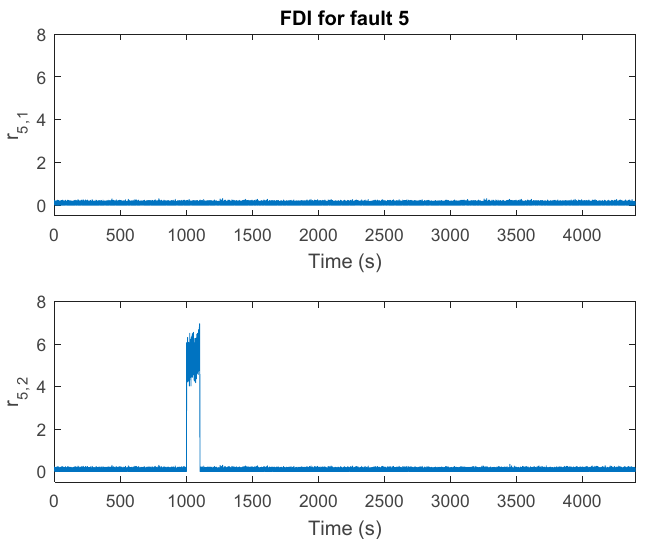
Figure 9. The abrupt fault in the speed of the generator in the period time of 1000 to 1100 s.